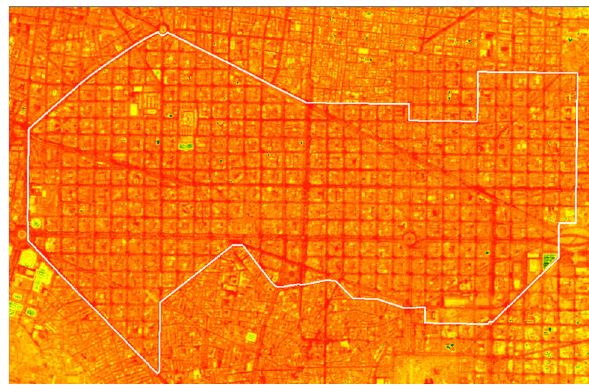
Figure 13. LST September 2014 (ICGC)